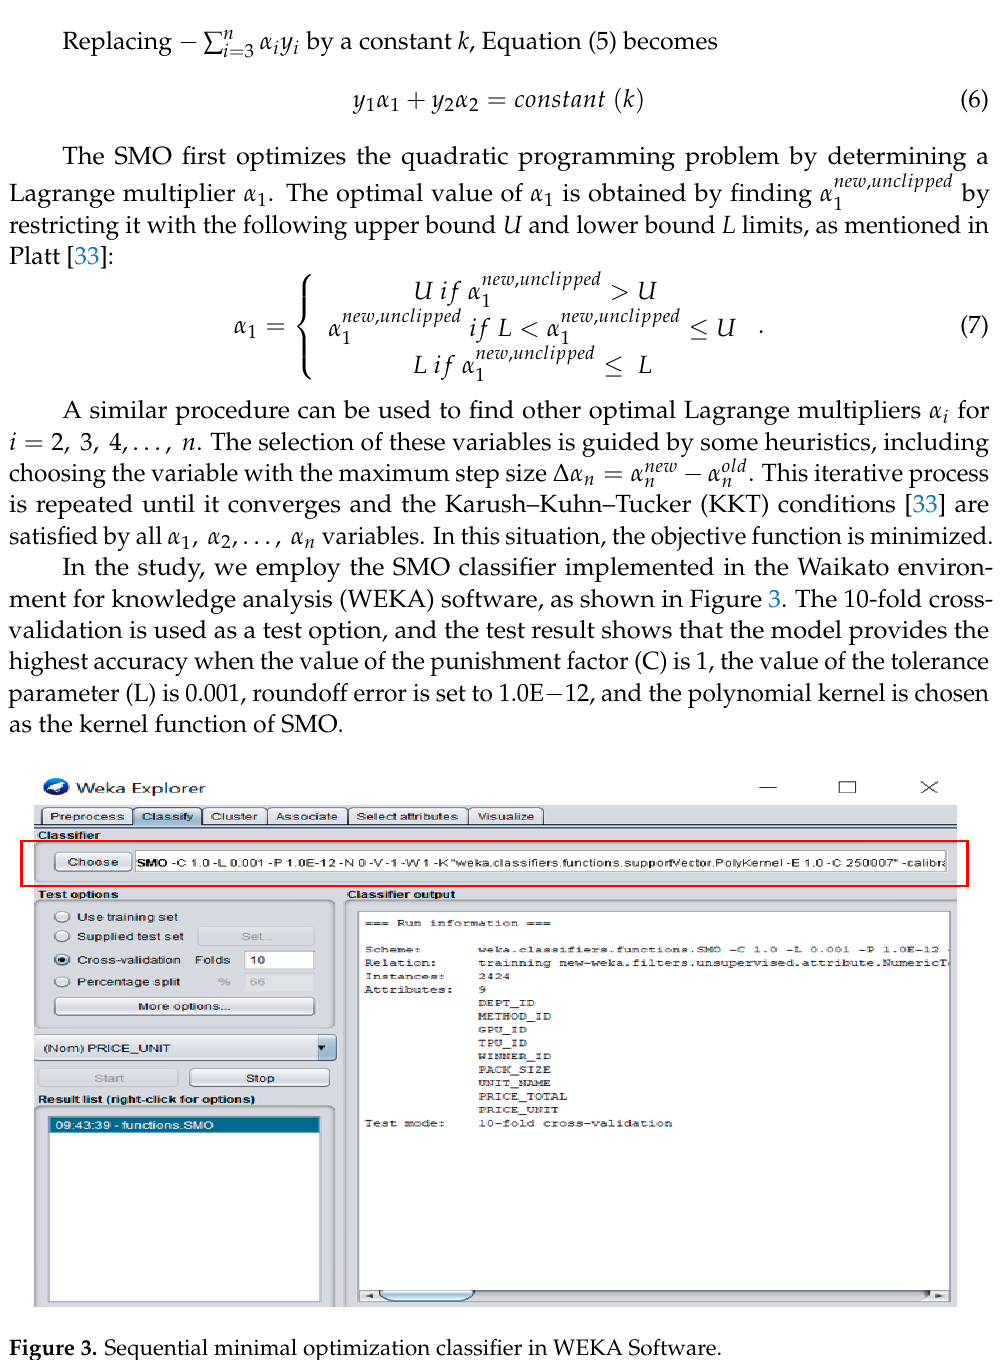
Figure 3. Sequential minimal optimization classifier in WEKA